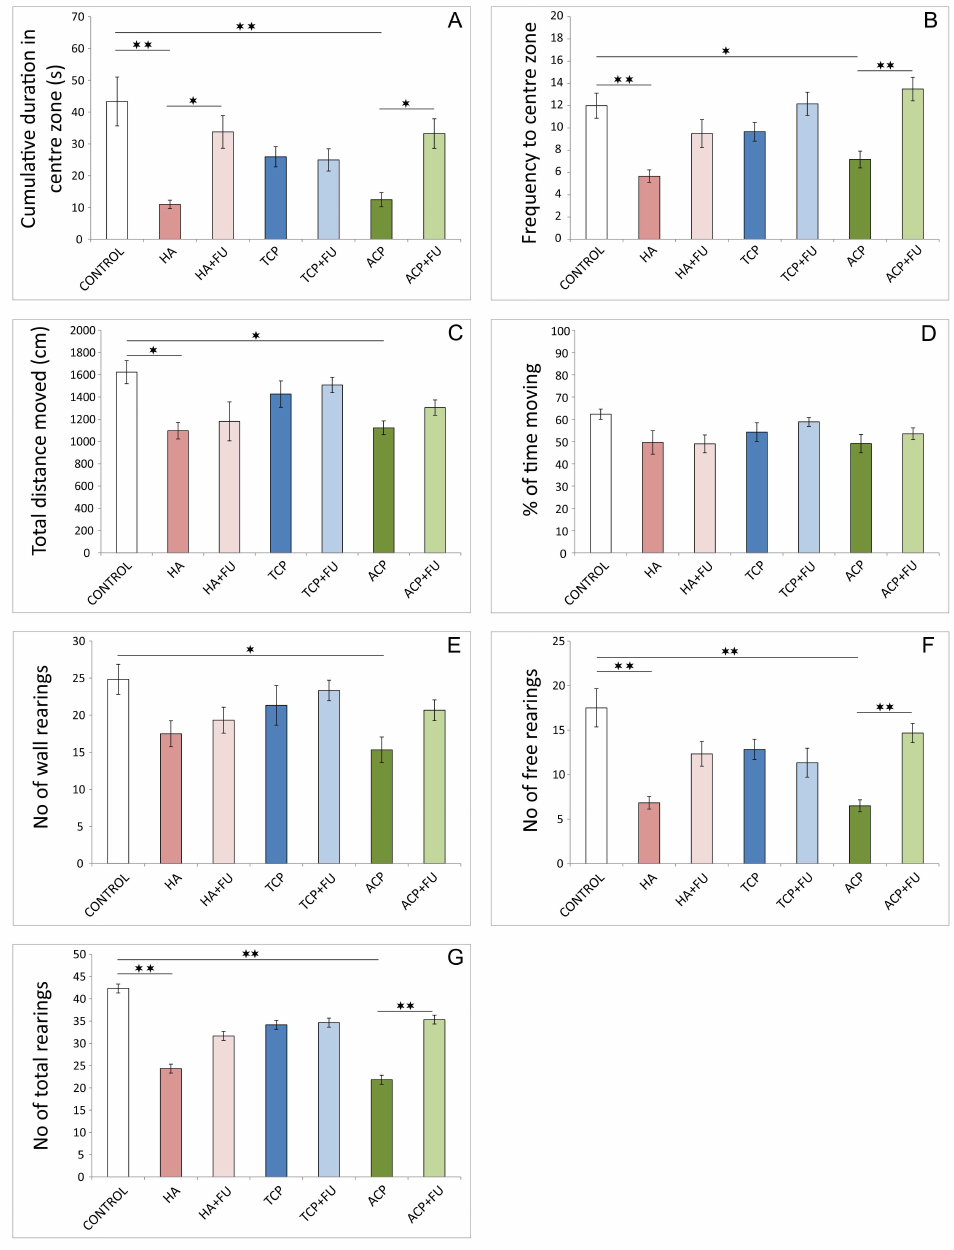
Fig. 1. Anxiety indicators were obtained in the open field test (6 per group). (A) Cumulative duration in the center zone. (B) Frequency to center zone. (C) Total distance moved. (D) Percentage of time moving. (E) The number of wall rearings. (F) The number of free rearings. (G) The number of total rearings. HA – hydroxyapatite; HA + FU – hydroxyapatite and Filipendula ulmaria extract; TCP – tricalcium phosphate hydrate; TCP + FU – tricalcium phosphate hydrate and Filipendula ulmaria extract; ACP – amorphous calcium phosphate; ACP + FU – amorphous calcium phosphate and Filipendula ulmaria extract. The graph bars present mean ± SEM, * represents a significant difference p < 0.05, ** represents a significant difference p <